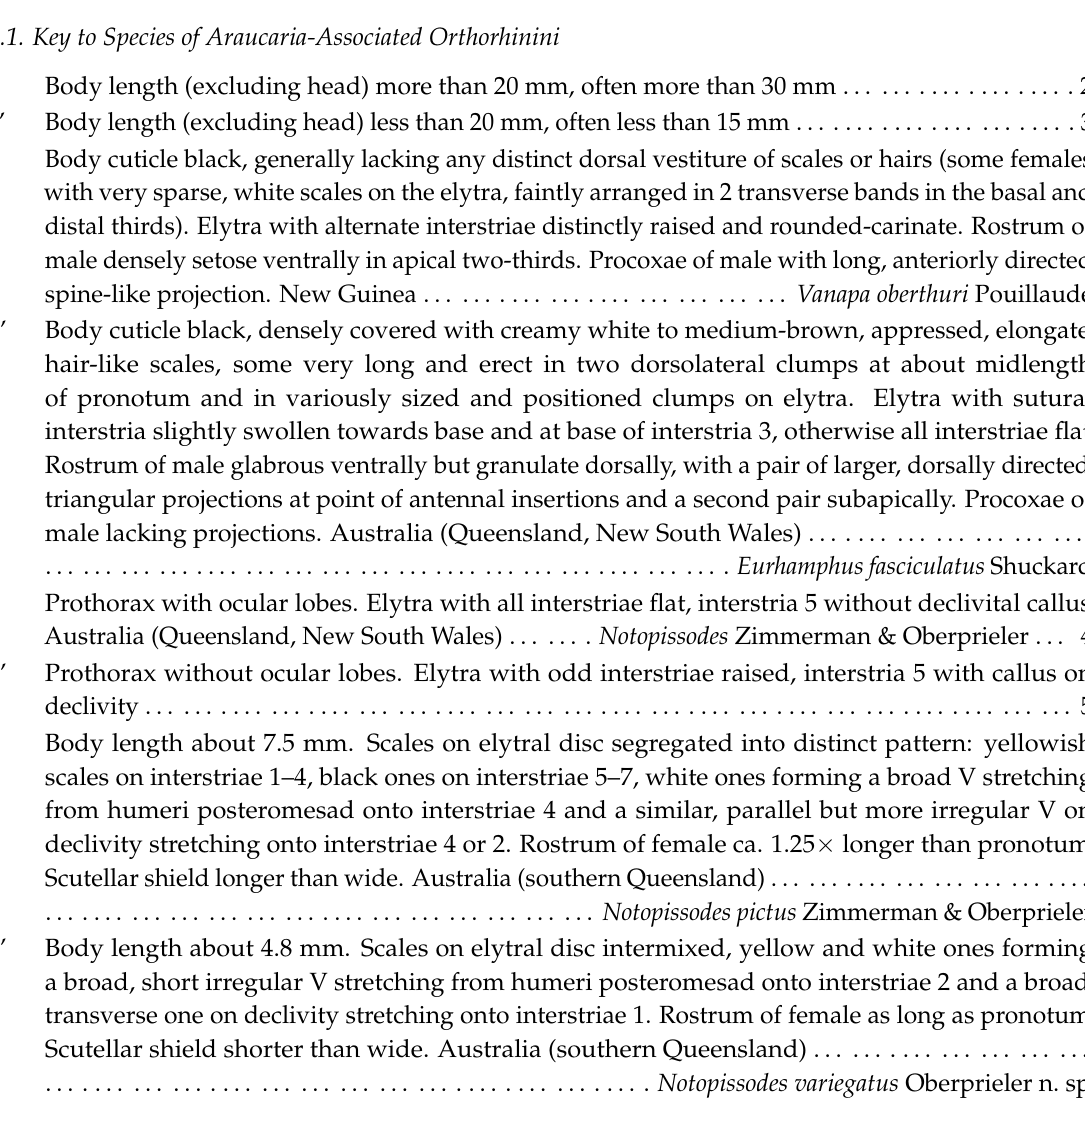
a broad, short irregular V stretching from humeri posteromesad onto interstriae 2 and a broad, transverse one on declivity stretching onto interstriae 1. Rostrum of female as long as